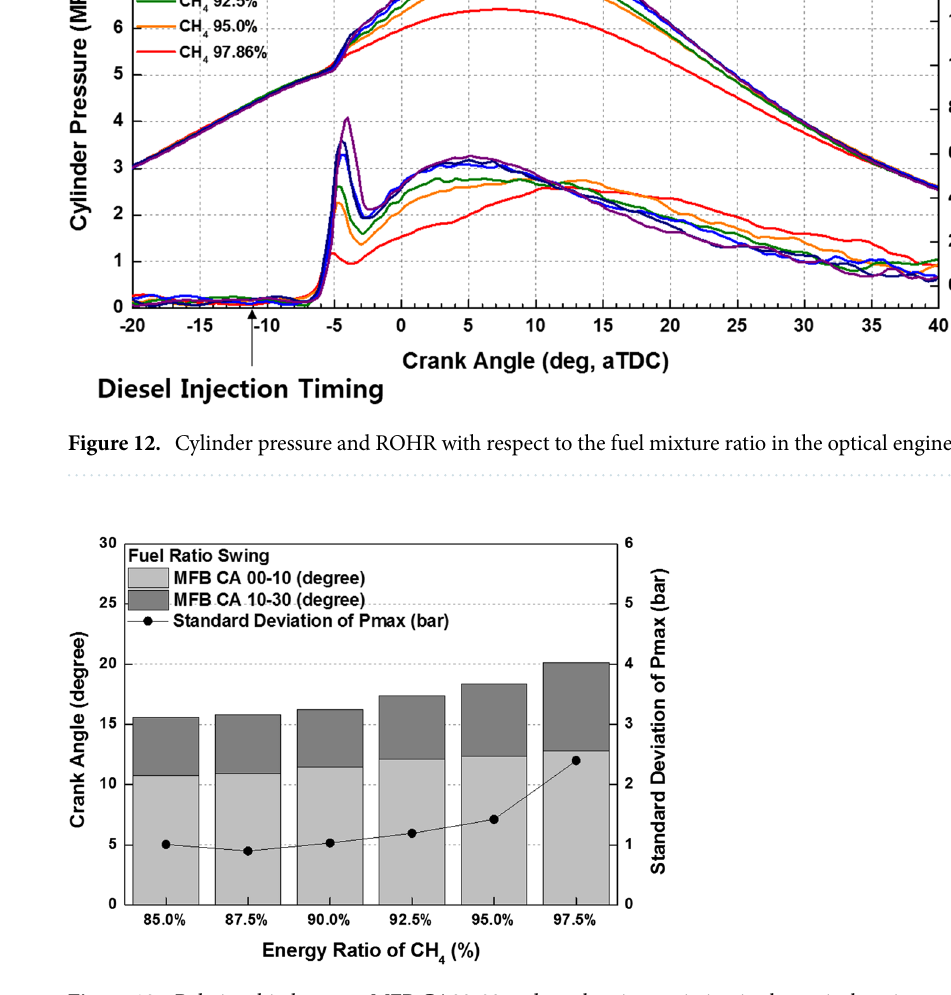
Figure 13. Relationship between MFB CA00-30 and combustion variation in the optical